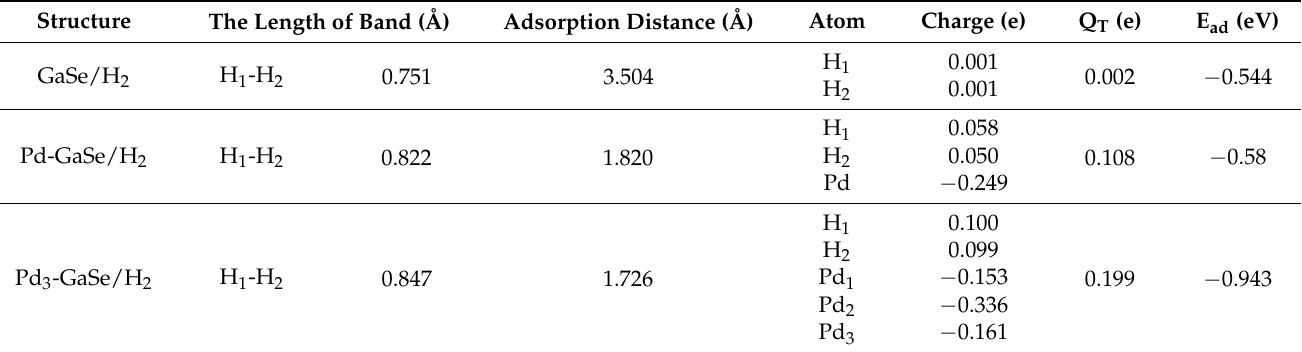
Table 1. Adsorption characteristic parameters of H 2